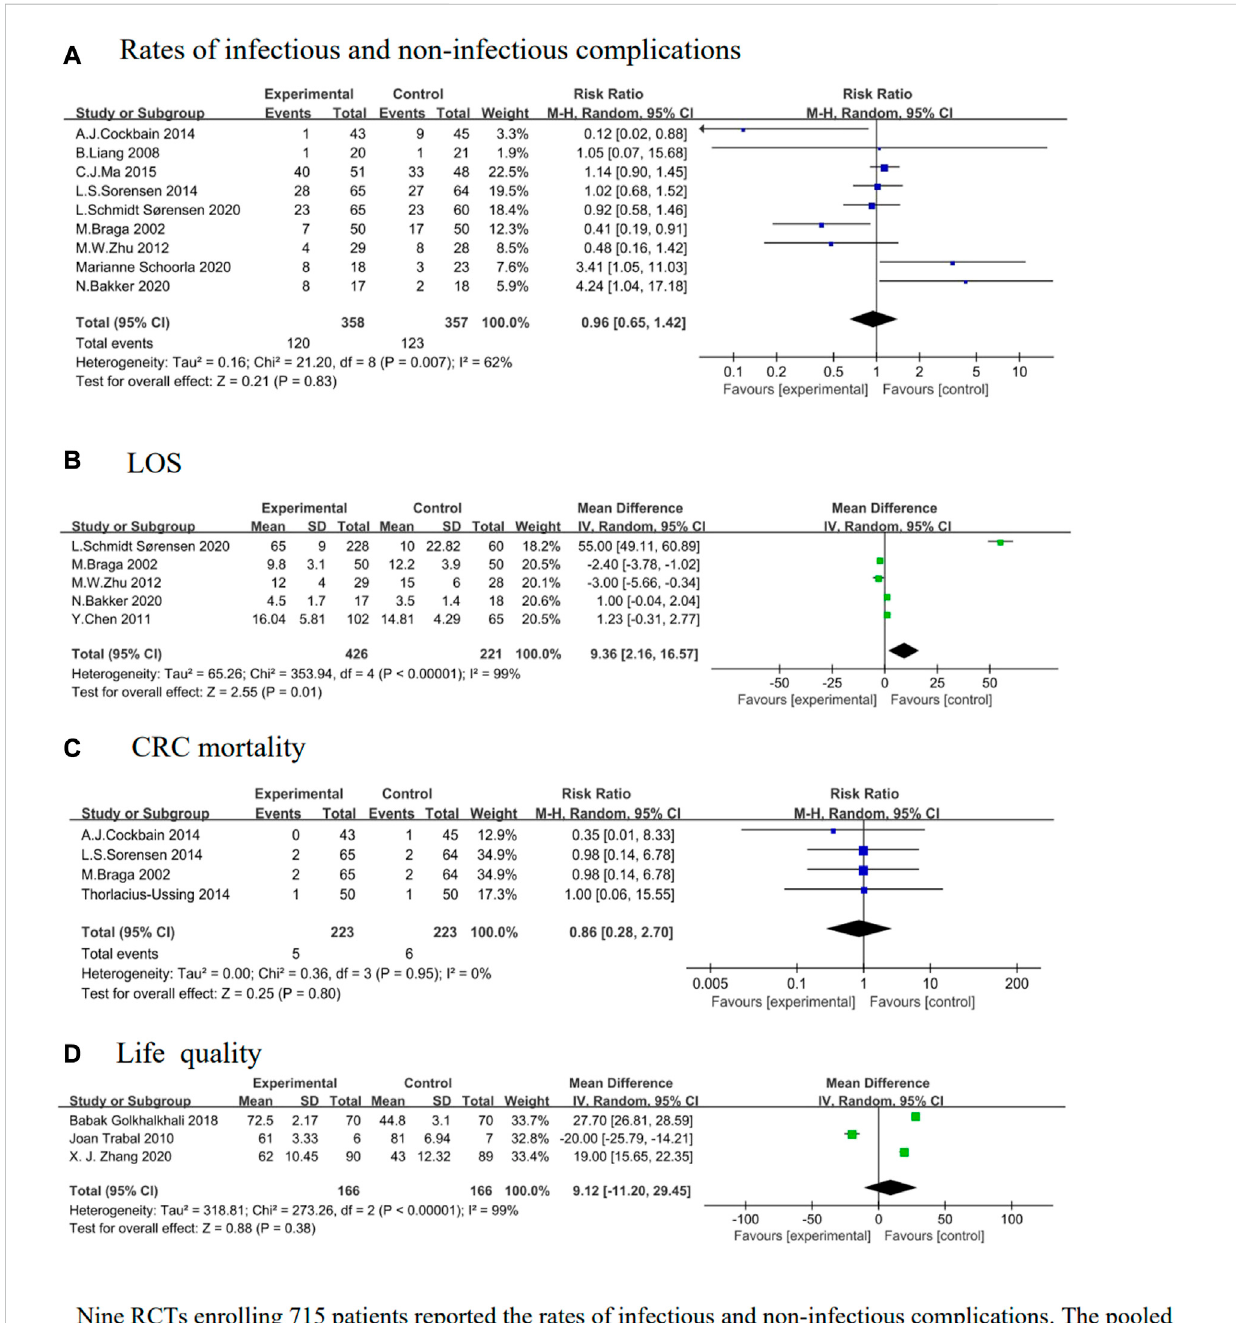
FIGURE 5 Effect of O3FAs onrates of infectious and non-infectious complications (A) ,LOS (B) , CRC mortality (C) , life quality (D) .